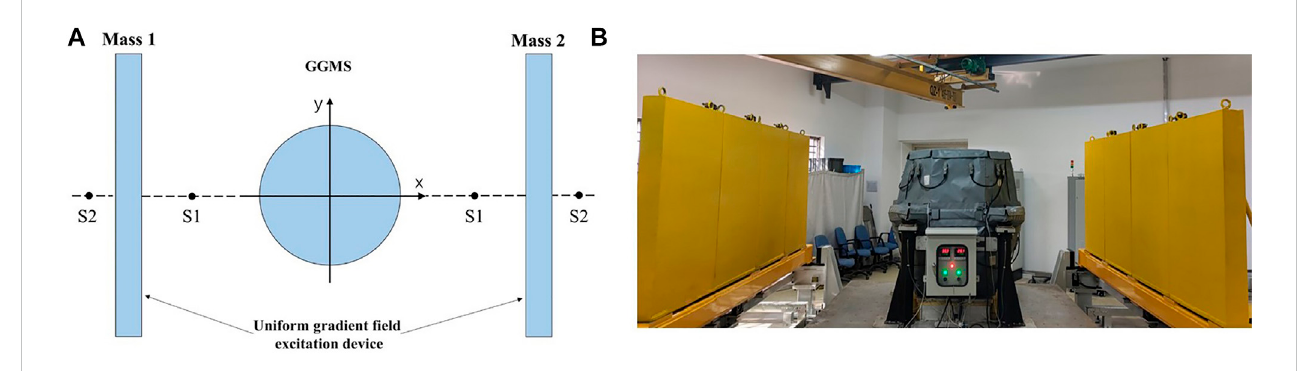
FIGURE 5 Schematic diagram of static accuracy test of GGMS (A) and test scene (B) .